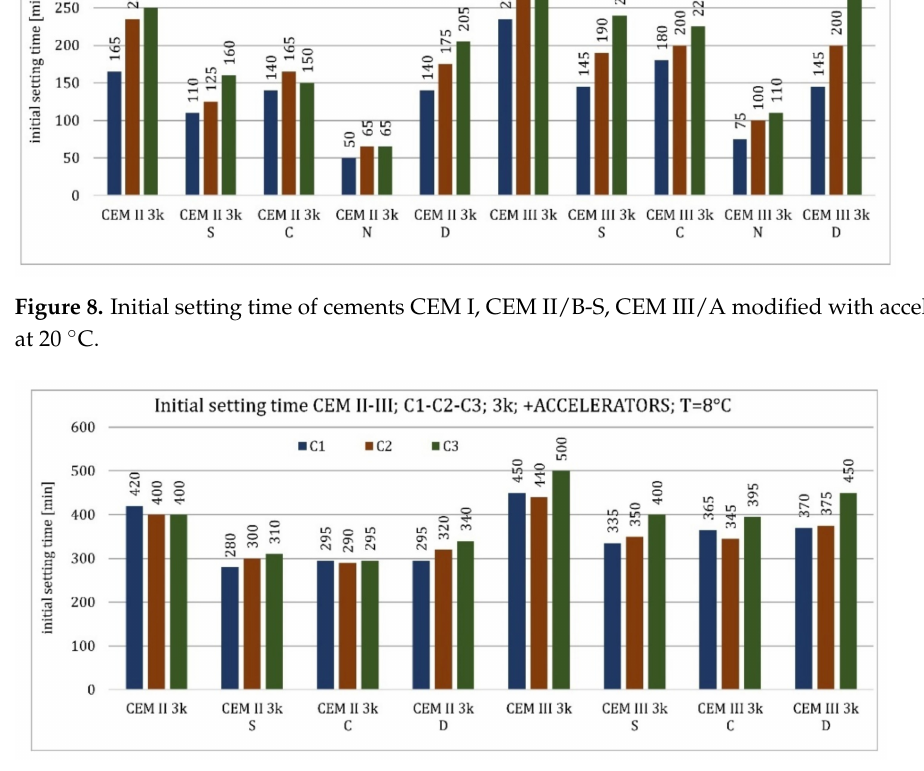
Figure 9. Initial setting time of cements CEM I, CEM II/B-S, CEM III/A modified with accelerators at 8 ◦